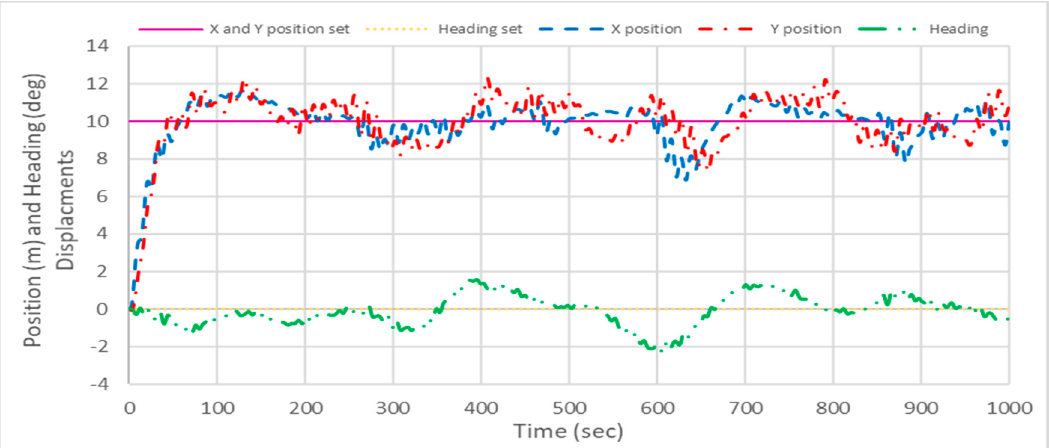
Figure 10. DP simulation with PID control showing platform X, Y position and heading angle.